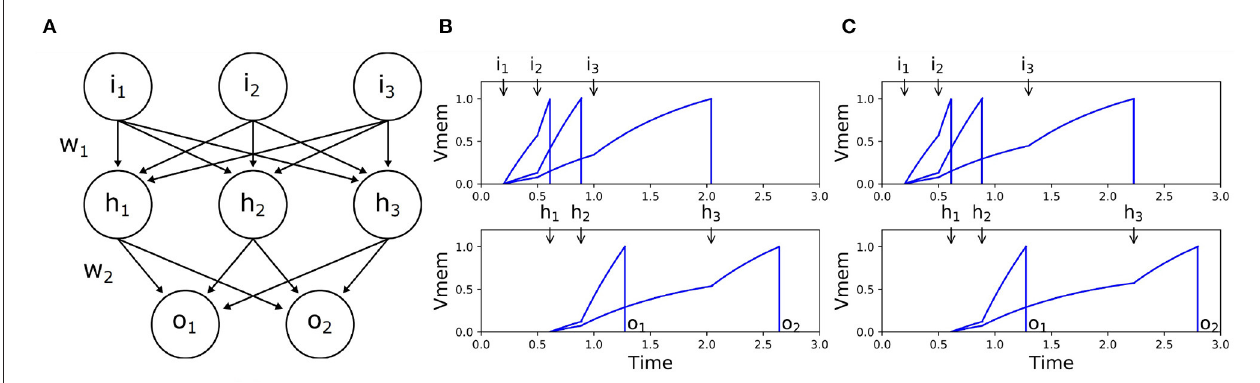
1.0. (C) Input-output spike times when =